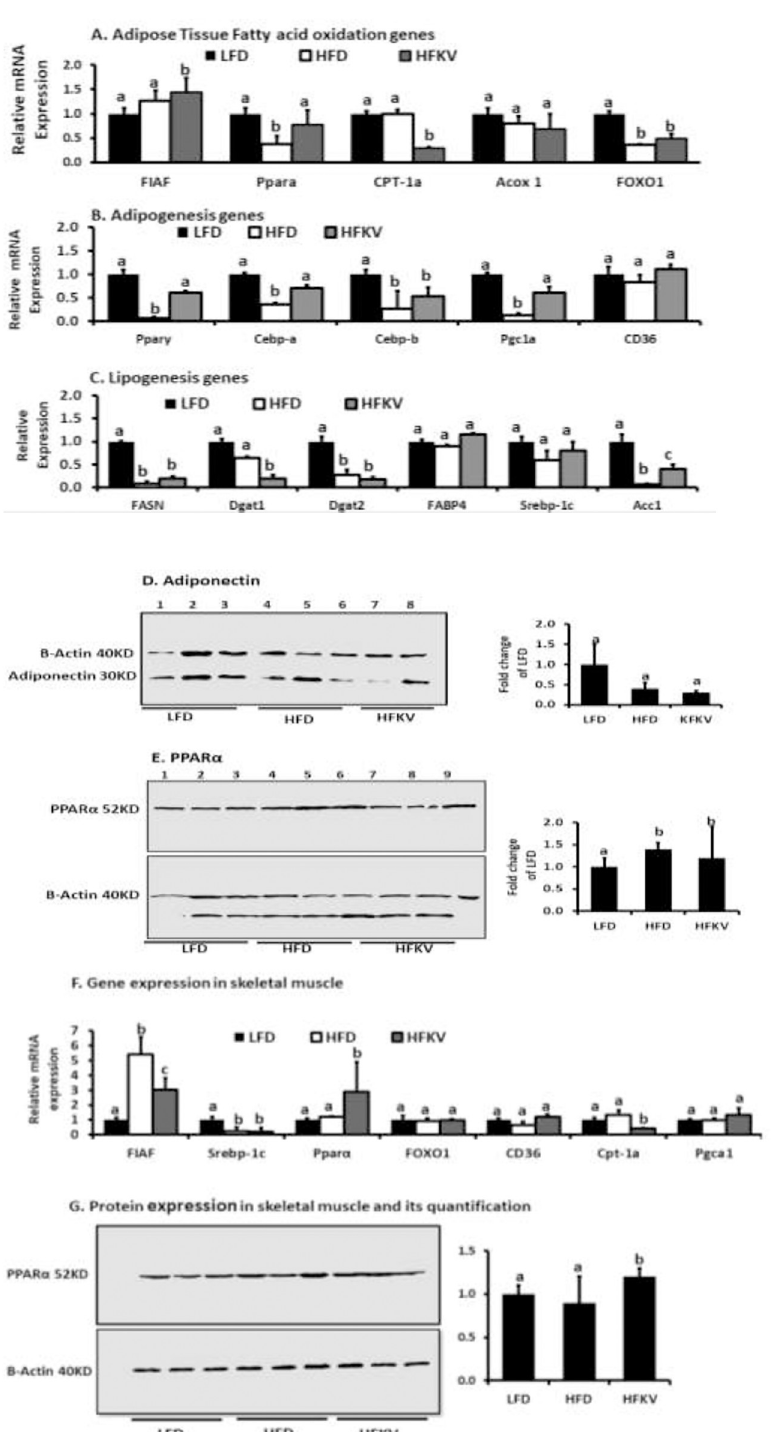
Fig 7. Gene expression and protein expression in adipose tissue and skeletal muscle. Gene expression was determined by qPCR and Cq values for each gene and that of β -actin as reference gene were used to calculate gene expression by calculating 2 - ΔΔ CT . The bar charts next to the western blots shows quantification of the western blot band in image J and after ANOVA. (A). Genes involved in fatty acid oxidation (B). Genes involved in adipogenesis. (C). Markers of adipose tissue lipogenesis. (D). Protein expression of Adiponectin. HFD decreased adiponectin expression and HFKV had no effect (P = ns). ( E). Protein expression of PPAR α . HFD decreased PPAR α expression and HFKV